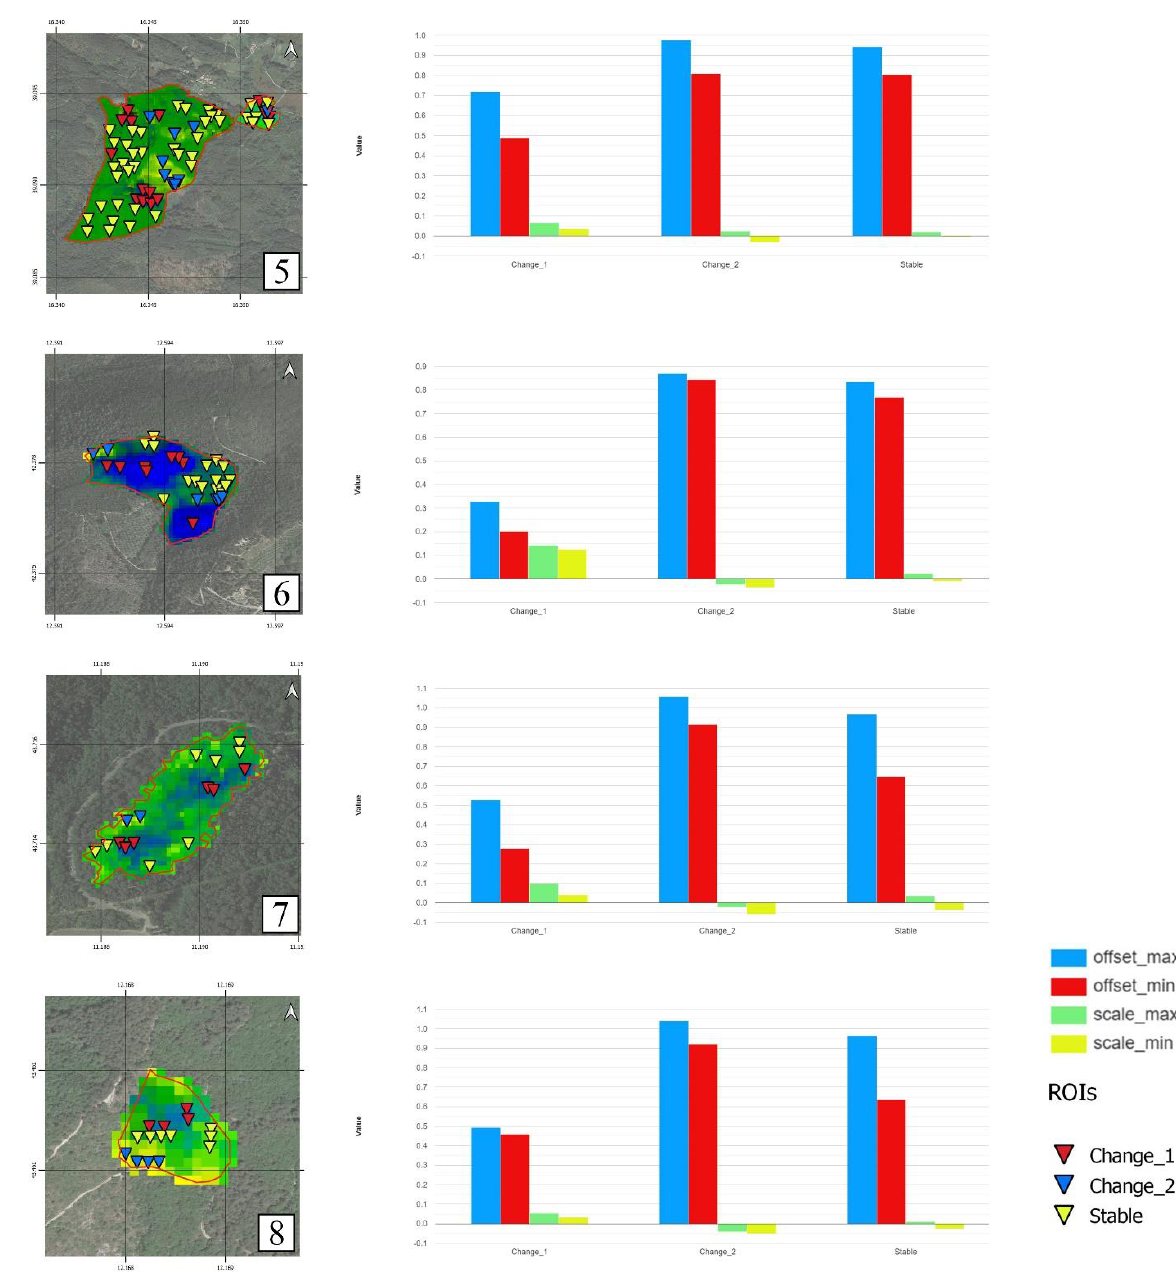
Figure 7. Events 5–8 (referring to IDs in Table 1). Overview image of analyzed cases (RGB: slope, Figure 7. Events 5 – 8 (referring to IDs in Table 1). Overview image of analyzed cases (RGB: slope, offset, slope) and graph of pixel value in selected offset, slope) and graph of pixel value in selected ROIs.